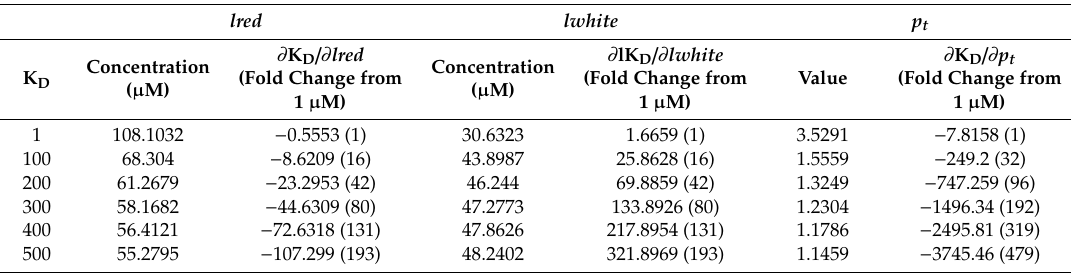
Table 1. Values for lred , lwhite and p t , and first derivatives thereof over a range of K D s for the standard system where p0 is 80 µ M, l0 is 50 µ M and the red and white chambers have standard volumes of 100 and 300 µ L, respectively. A unit change in lred concentration at 55.3 µ M (K D of 500 µ M) results in a 193-fold change in K D readout compared to the 108 µ M concentration (K D 1 µ M level). Similar changes are seen in the white chamber.